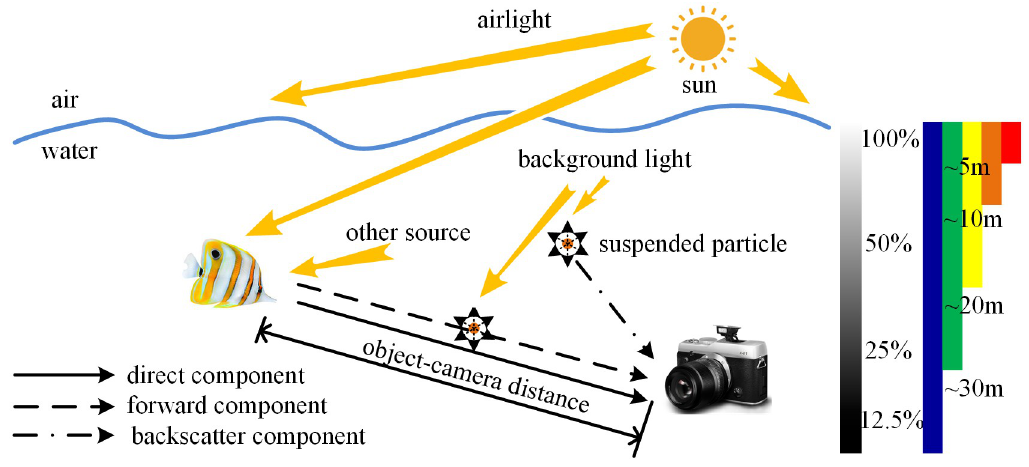
Fig 1. Underwater optical imaging